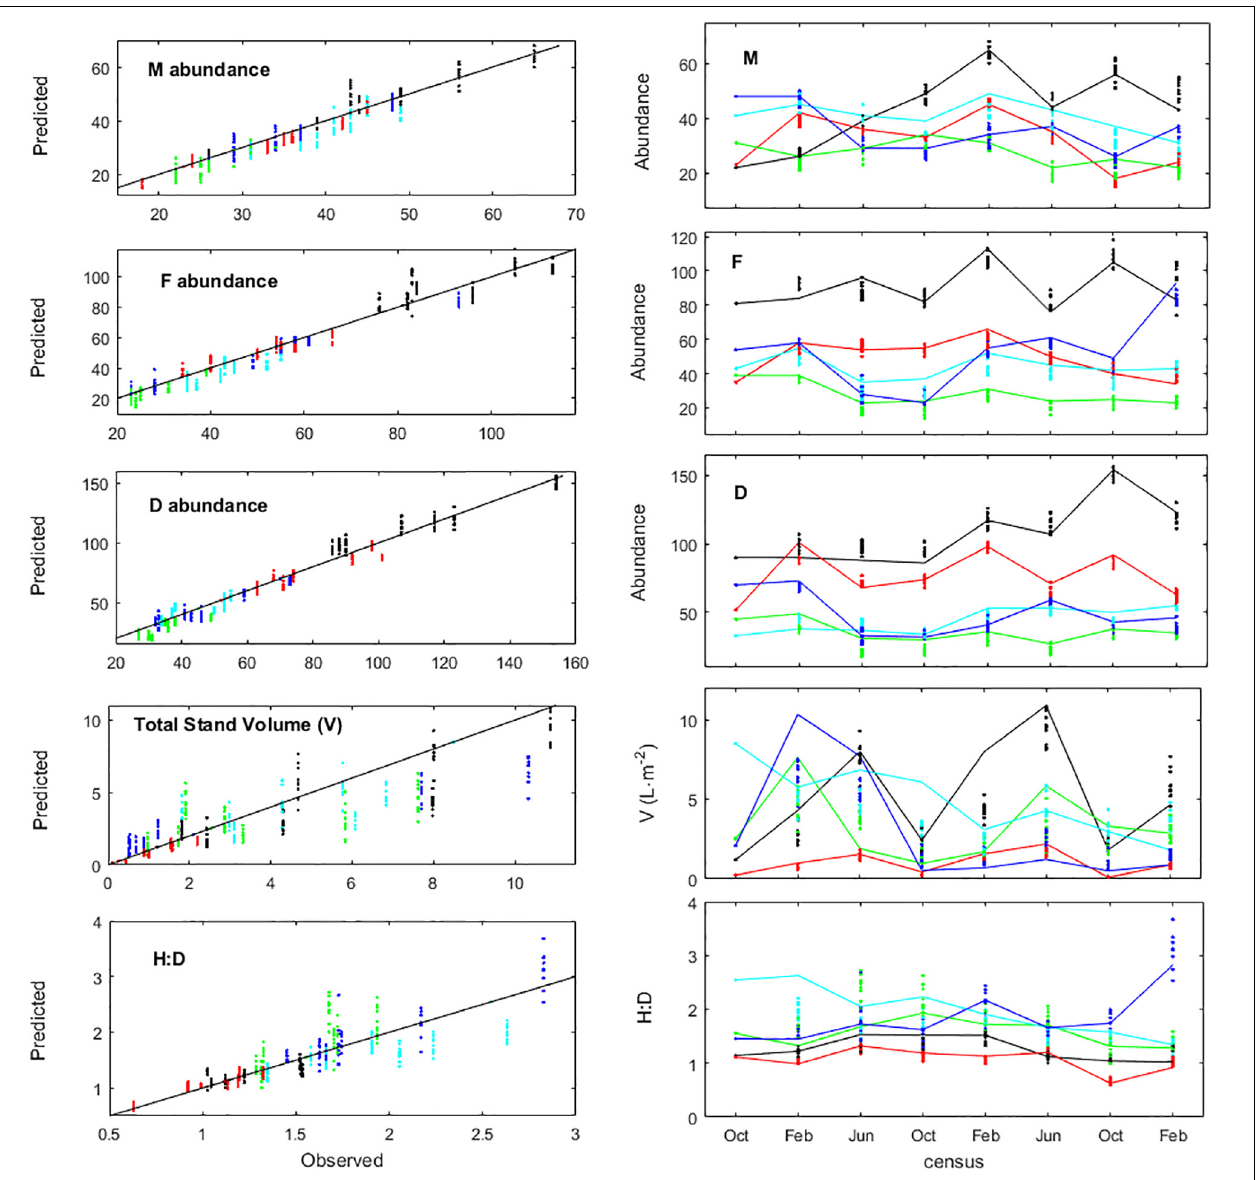
FIGURE 5 | Agarophyton chilense IBM calibration and validation from estimates of population properties, namely, abundances of males (M), females (F) and diploids (D), frond density (V) and haploid-to-diploid ratio (H:D). Observed properties compared against properties predicted from 10 runs of the IBM. Population properties estimated for plots Corral 1 (black), Corral 2 (red), Niebla 1 (green), Niebla 2 (light blue), and Niebla 3 (dark blue). Observations during February (Feb), June (Jun), and October (Oct). Left panes: standard (predicted:observed) plots with 1:1 gray solid line. Right panes: time series with observations (solid lines) and estimates (colored